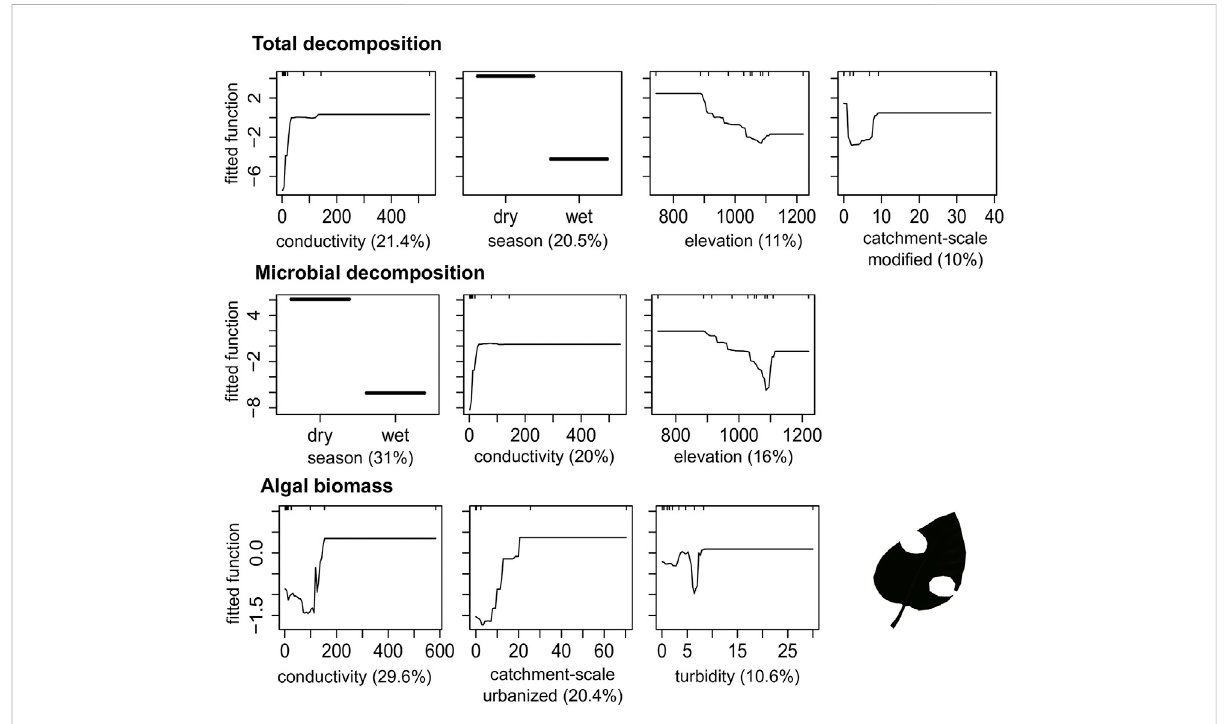
FIGURE 6 Boosted regressiontree(BRT) fi ttedfunctionsfor thebest performance modelsoffunctional metrics. Plotsare onlyshown for thosepredictors that explained more than 10% deviance in the metric. Rug plots show the distribution of data, in deciles, of the variable on the